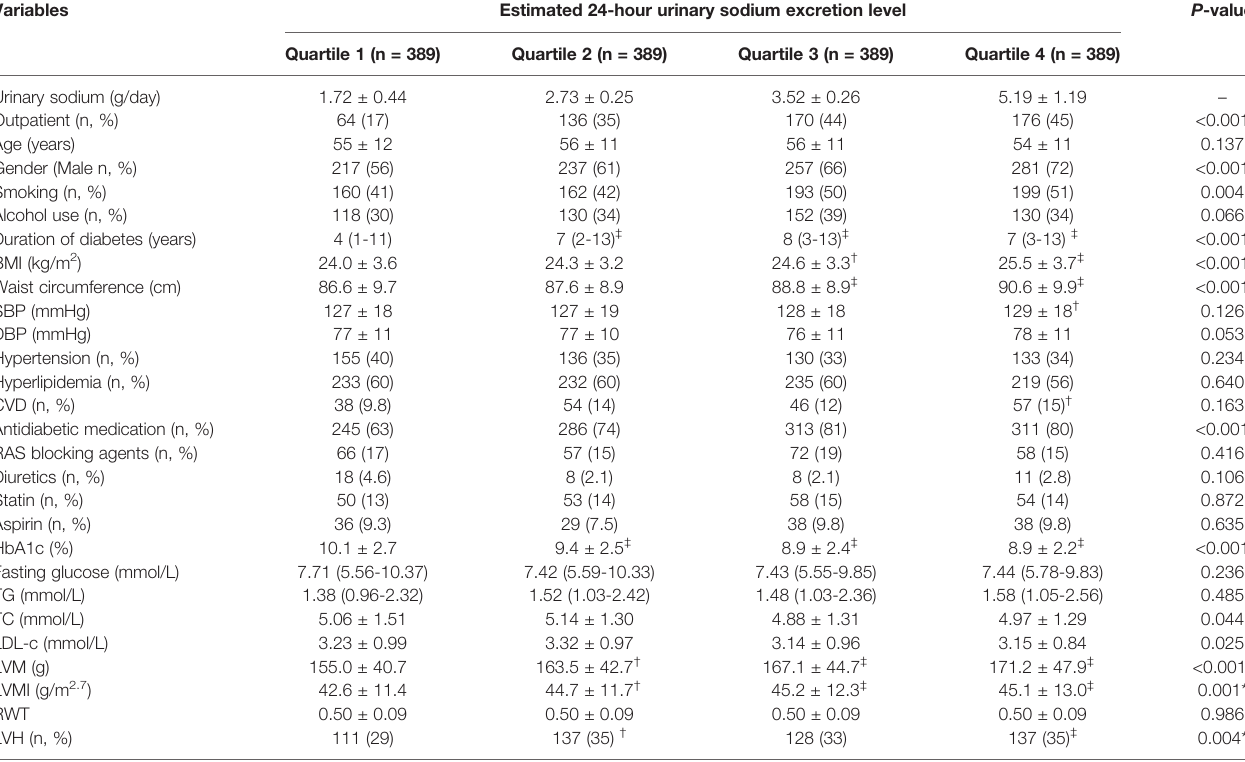
TABLE 1 | Characteristics of individuals categorized by quartile of urinary sodium